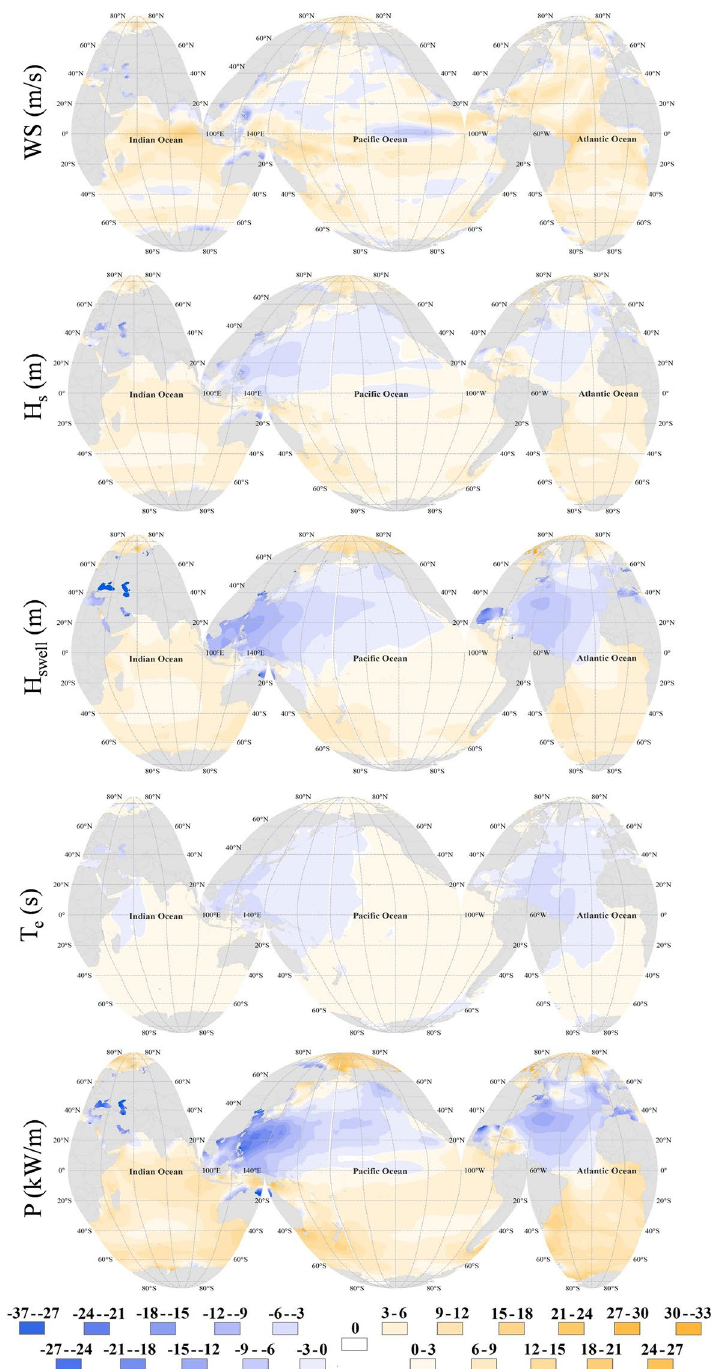
Figure 2. Relative change of annual mean values of different parameters in Per_2 compared to Per_1 (%). The figure has been generated using ArcGIS 10.2 and Natural Earth-Free vector and raster map data @